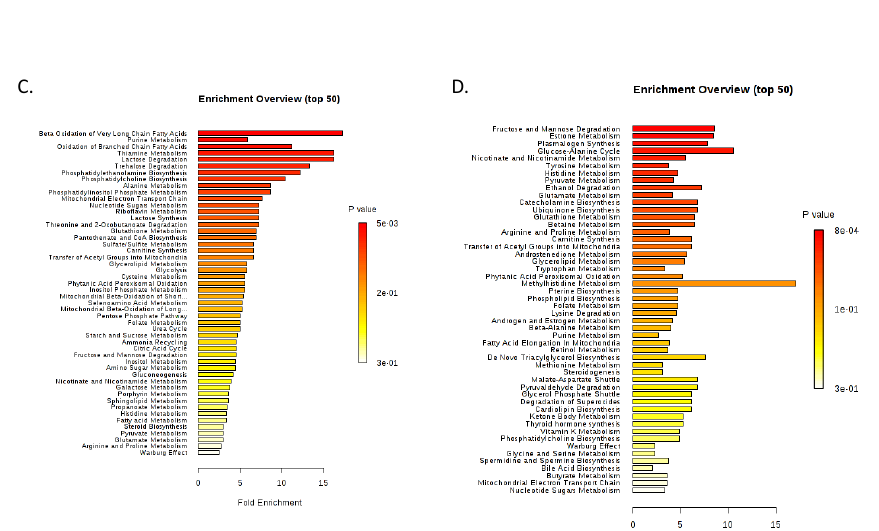
Figure 3. Excessive metabolic dysregulation is present in myeloid cells of MDS patients. Metabolite set enrichment analysis (MSEA) was carried out by MetaboAnalyst (v4.0). Enriched pathways were ranked by significance (see color scale) calculated by the MetPa method implemented in MetaboAnalyst (v4.0). ( A ) MDS vs. control metabolome, ( B ) G2 vs. control metabolome, ( C ) G1 vs. control metabolome, and ( D ) G1 vs. G2 metabolome. G1: Di ff erentiating myeloid lineage cells isolated from MDS BM aspirates containing < 5% blasts. G2: Di ff erentiating myeloid lineage cells isolated from MDS BM aspirates containing ≥ 5%